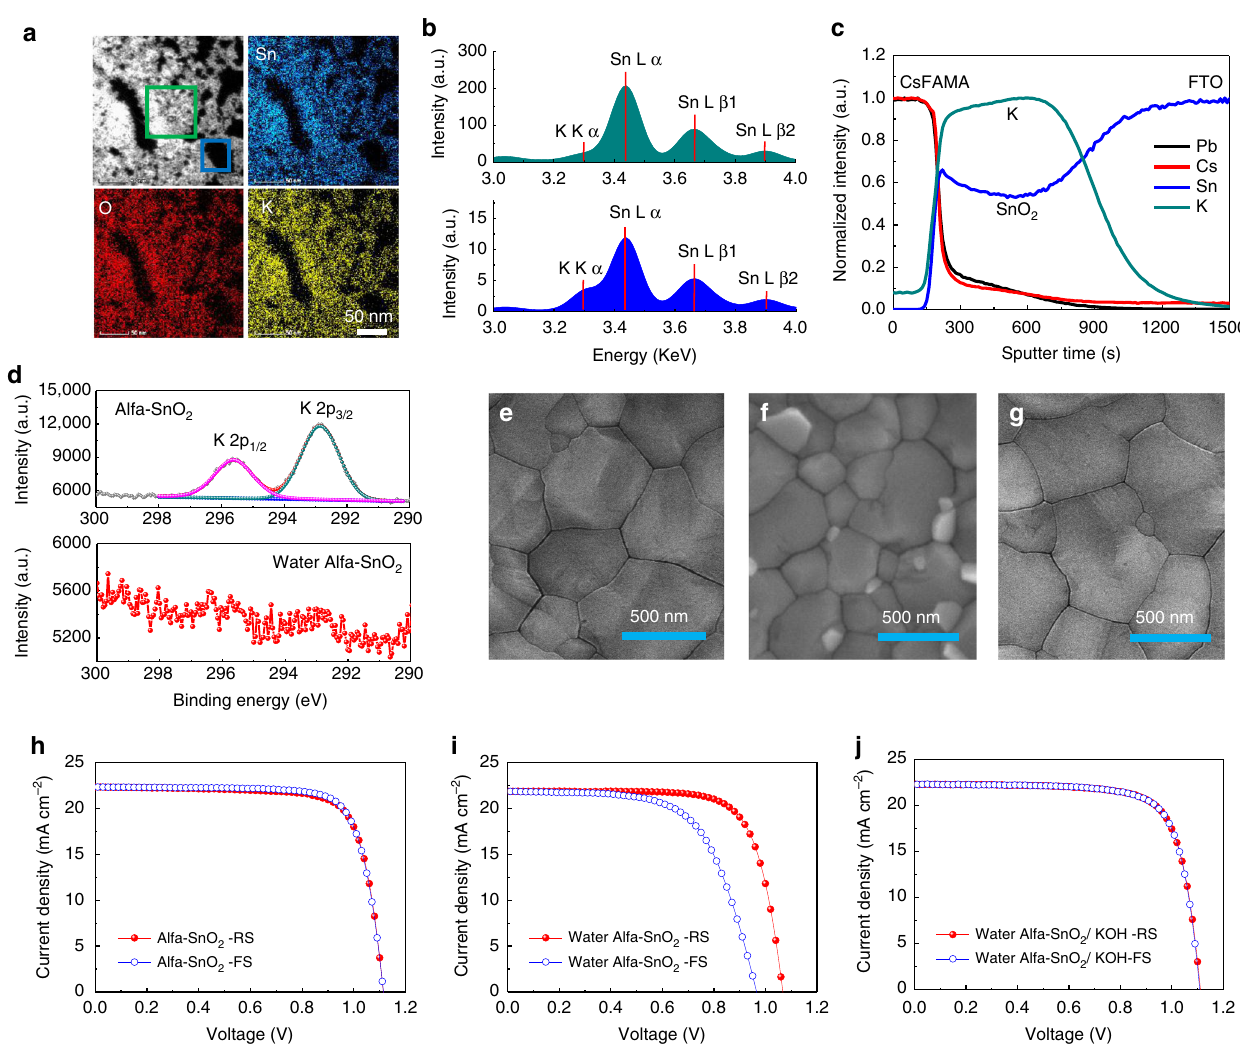
Fig. 2 Characterization of the Alfa – SnO 2 and corresponding performance of PSCs. a The STEM – EDX images of the Alfa – SnO 2 colloidal. b The corresponding EDX spectra consistent to the boxed area. c The normalized SIMS results of the CsFAMA perovskite deposited on Alfa – SnO 2